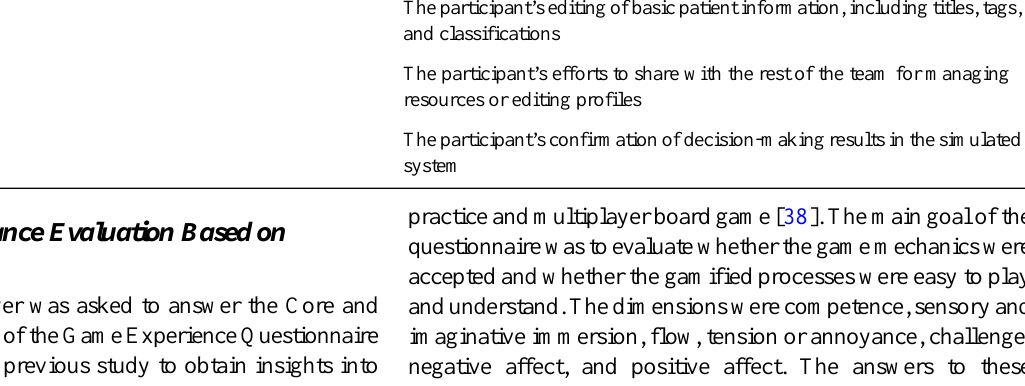
Triage placeNormal modules responsibleRed module responsible A quarter of the tokens the receiving module earns but –1 token for every 2